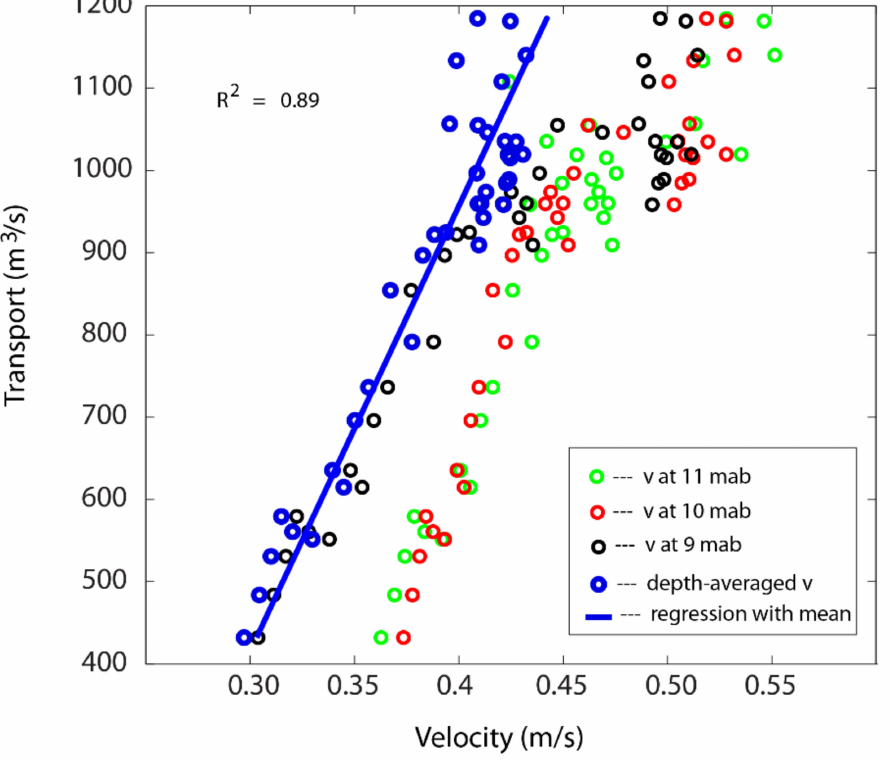
Figure 7. Linear regression between the velocity measured by the bottom-mounted Teledyne RDI ADCP at site 1 with the total cross channel transport measured by the vessel-based M9 ADCP during the first deployment. The circles are for velocity from the bottom-mounted ADCP at various heights (meter above the bottom, or mab). The blue circles are the depth-averaged velocity from the bottom-mounted